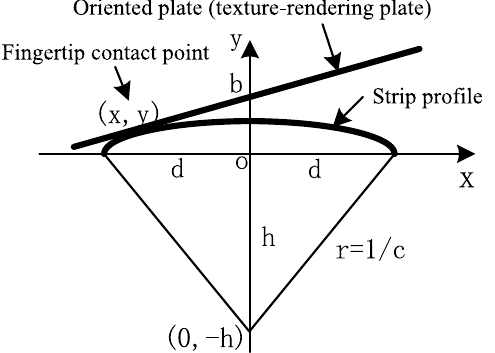
Fig. 4. Illustration of virtual shape and the control of oriented plate. c is the strip curvature, r is the radius, d is the half length of the strip, ( o , (cid:3) h ) is the center coordinate, ( x , y ) is the fi ngertip contact point, and b is the intersection of the plate and y